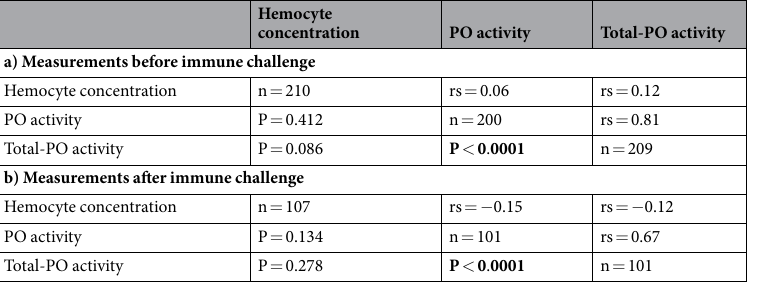
Hemocyte concentration PO activity Total-PO activity